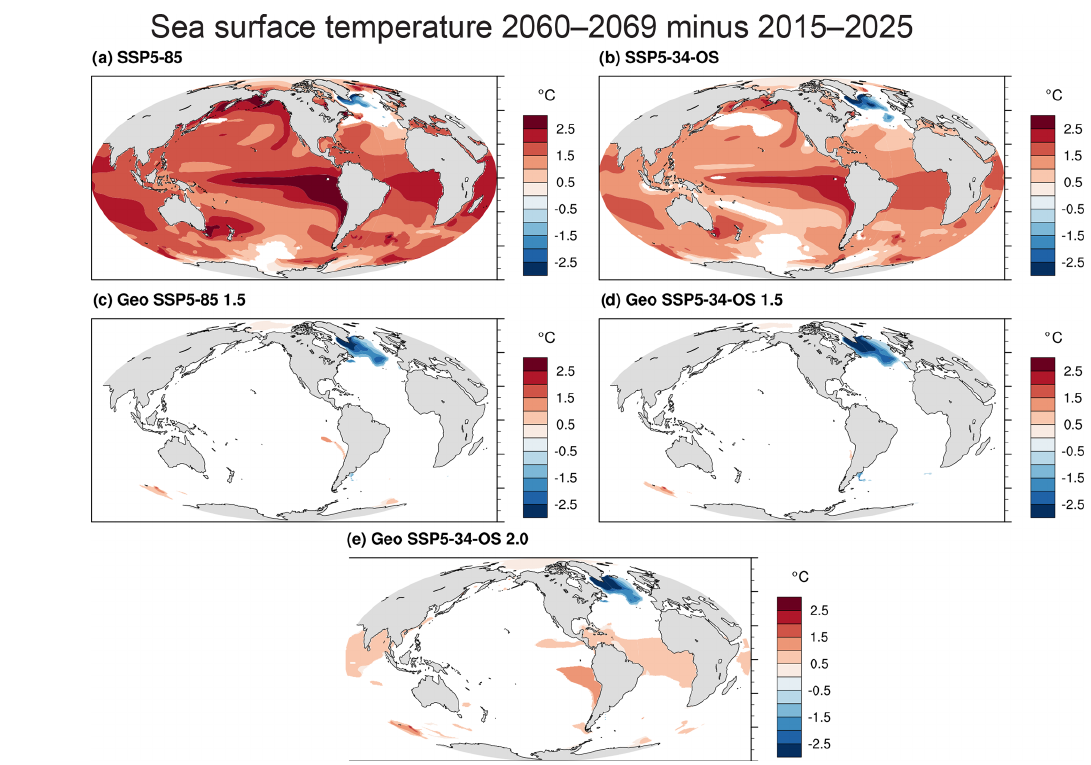
Figure A3. Ensemble mean sea surface temperature (SST) in 2060–2069 relative to 2015–2025 for different scenarios (different panels). Regions shaded in color are significant with 95% confidence, assuming normally distributed